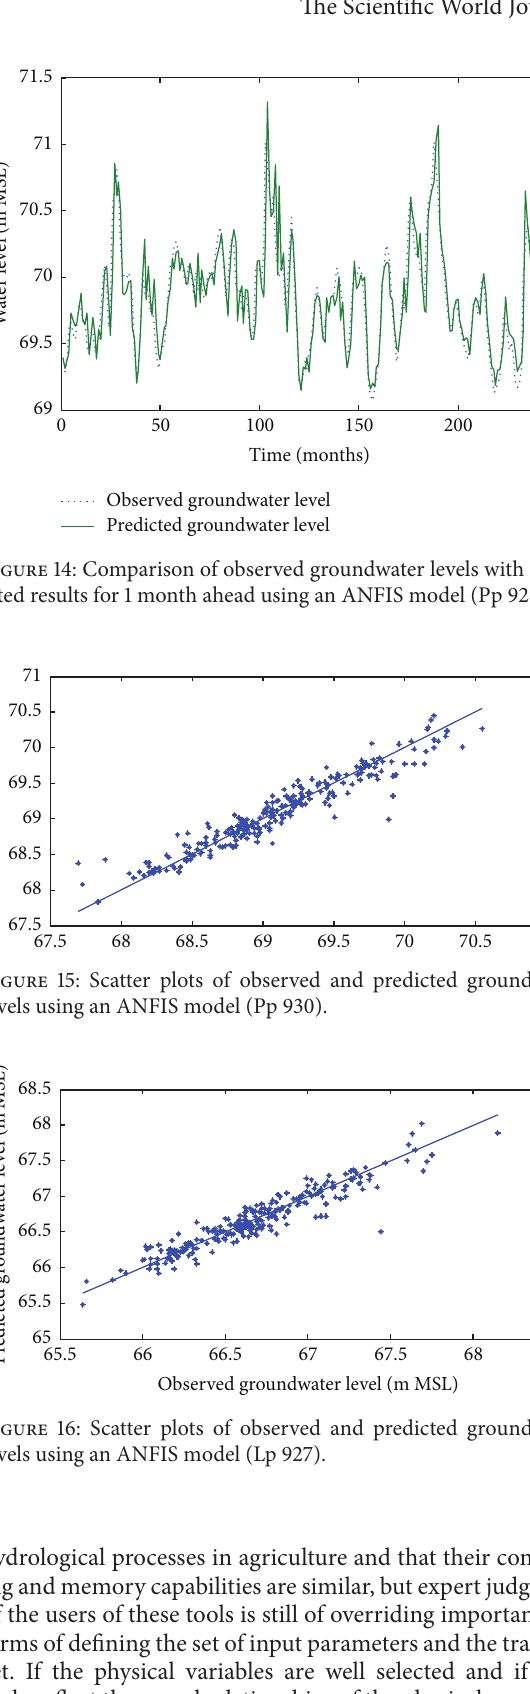
Figure 13: Comparison of observed groundwater levels with simu- lated results for 1 month ahead using an ANFIS model (Lp 927).